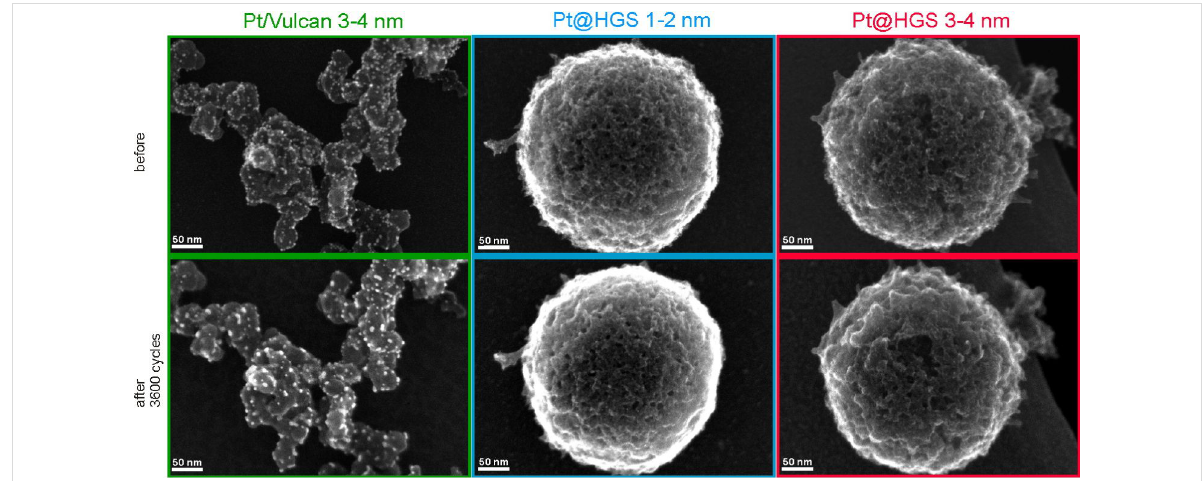
Figure 4: IL-SEM of Pt/Vulcan 3–4 nm (green), Pt@HGS 1–2 nm (blue) and Pt@HGS 3–4 nm (red) after 0 (top) and after 3600 (bottom) potential cycles between 0.4 and 1.4 V RHE in 0.1 M HClO 4 at a scan rate of 1 V·s − 1 . IL-SEM visualizes the surface morphology of the materials, in